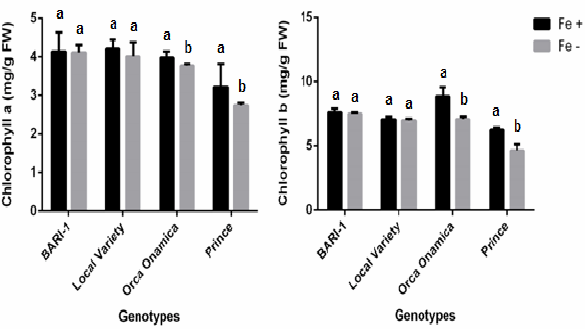
Fig. 1. Concentration of chlorophyll a and b in young leaves in a number of okra genotypes grown in Fe-sufficient (Fe+) and Fe-deficient (Fe-) hydroponic culture. Data were taken 3 weeks after Fe deficiency was imposed. Different letters indicate significant differences between means ± SD of treatments (n = 3), comparisons were done for Fe + and Fe -